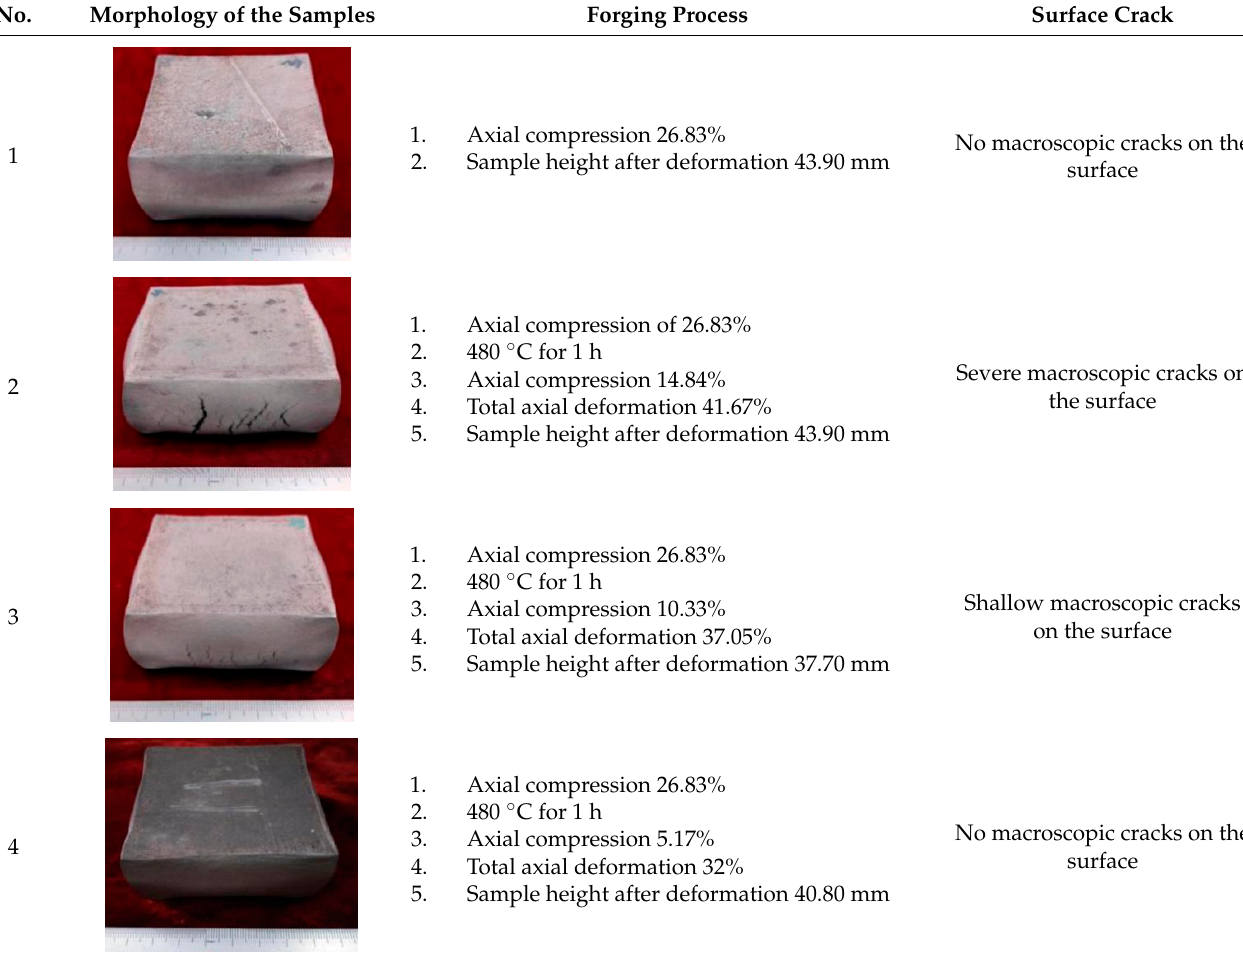
Figure 3. The samples morphology of the aluminum matrix composite: ( a ) Compression defor- mation amount of 32.43%; ( b ) Compression deformation amount of 34.28%.